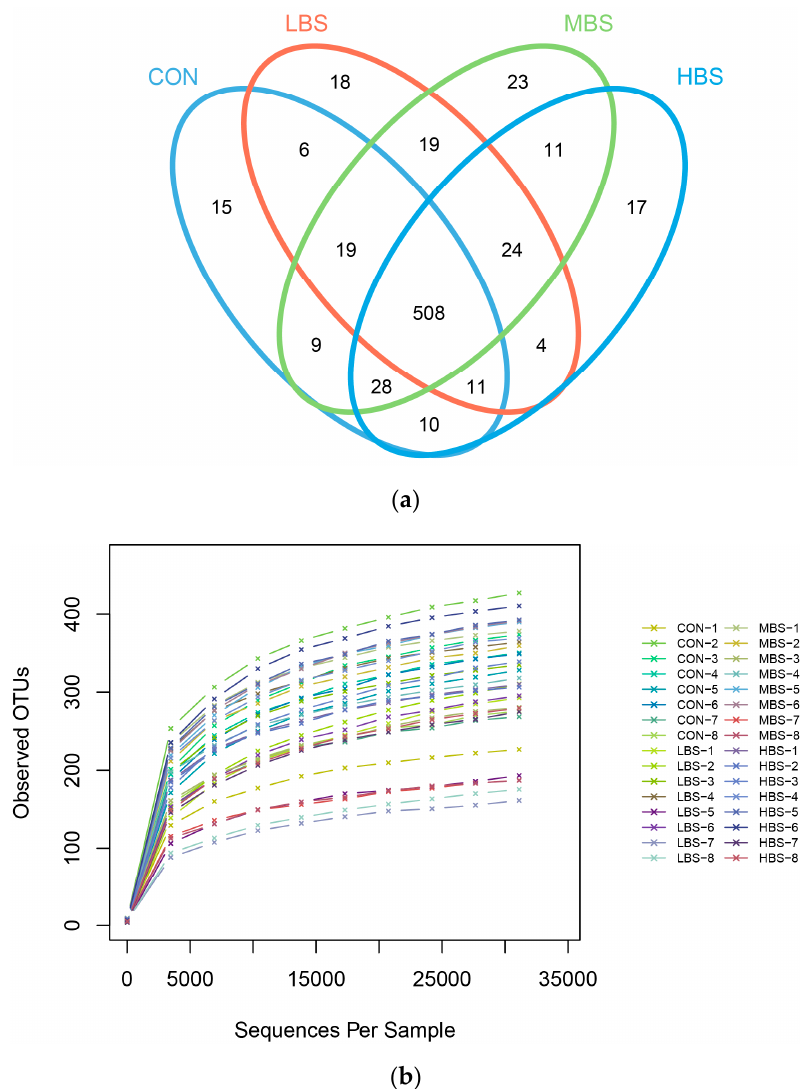
Figure 2. Ruminal microbial operational taxonomic units (OTUs) with different levels of BSS supplementation. CON: basal diet without supplement; LBS: basal diet low supplemented with 0.25 g of BSS/kg of DMI; MBS: basal diet medium supplemented with 0.5 g of BSS/kg of DMI; HBS: basal diet high supplemented with 1 g of BSS/kg of DMI ( a ) Venn diagram of ruminal bacterial OTUs. The number of unique OTUs were represented by the unoverlapped portion of Venn diagram for each group. ( b ) Bacterial rarefaction curves based on OTUs were used to assess the depth of coverage for each sample.